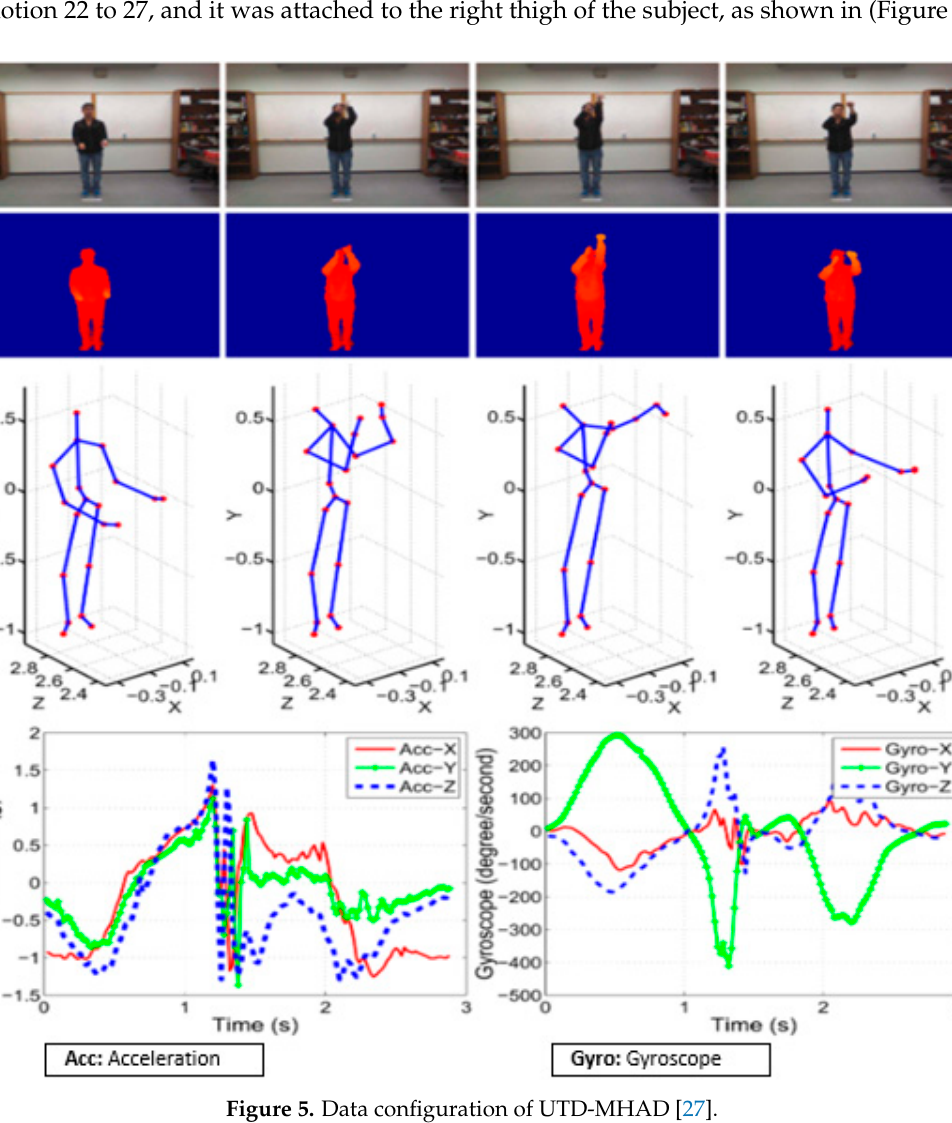
Figure 5. Data configuration of UTD-MHAD [27].